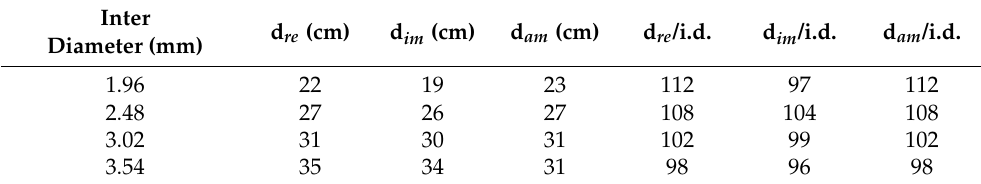
Table 2. Critical separation distance values of different inner